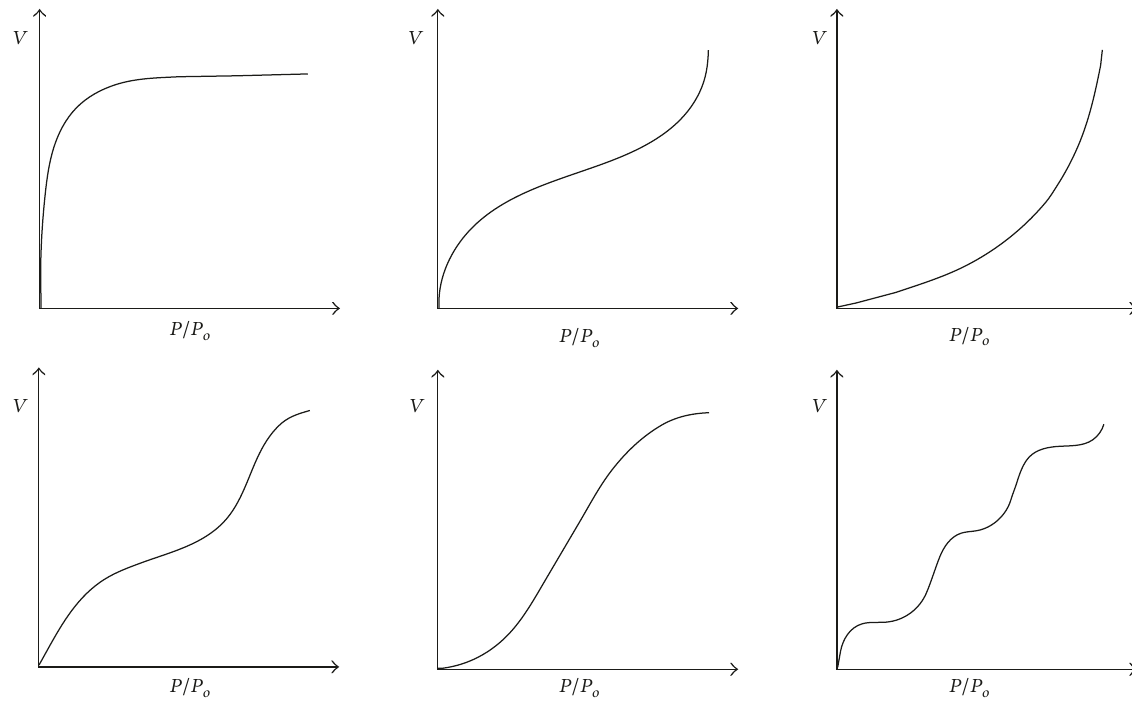
Figure 1: Classification of BDDT adsorption isotherms (from Brunauer, Sing et al., 1940).